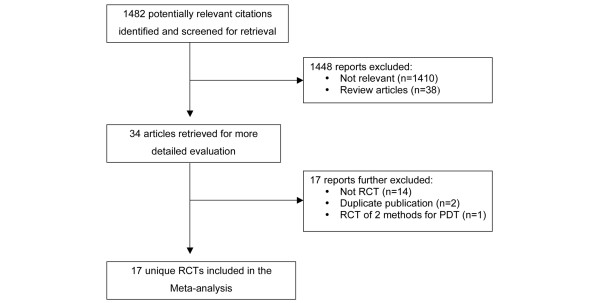
Quorum flow diagram summarizing trial flow and reasons for exclusion of studies. PDT, percutaneous dilatational tracheostomy; RCT, randomized clinical trial.